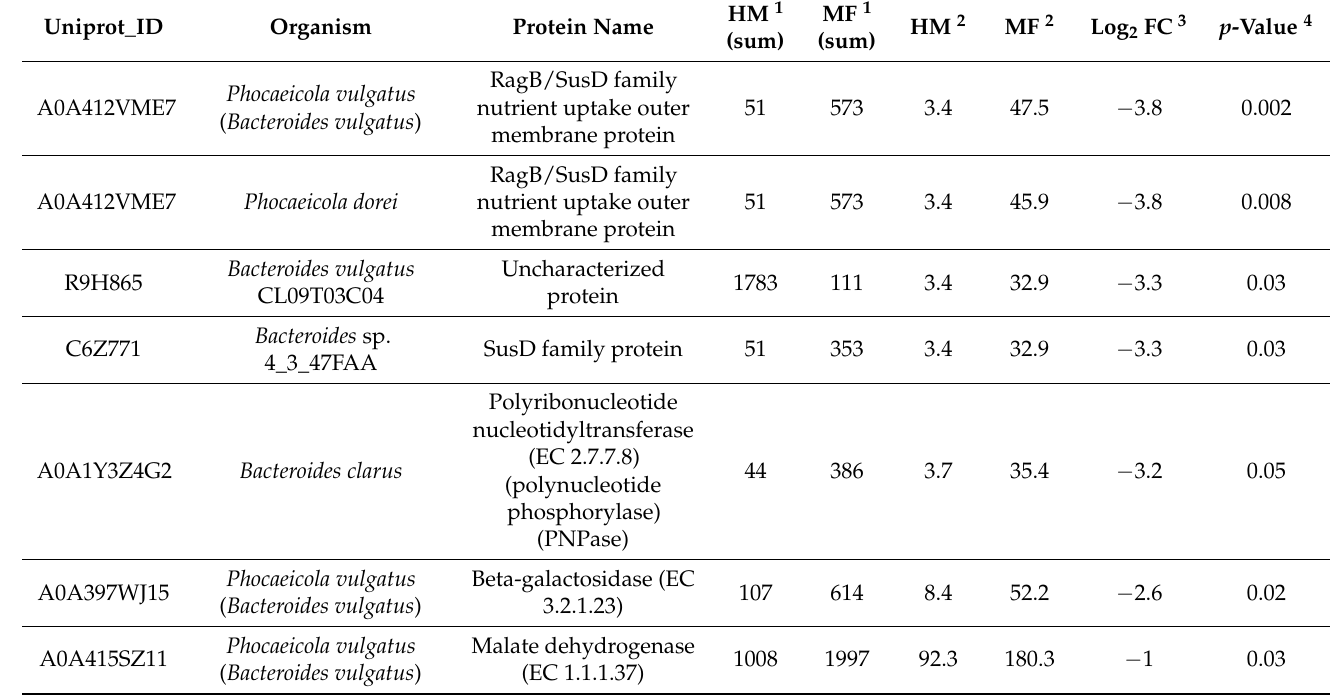
Table 2. Bacterial protein profile of cecal content of piglets ( n = 11/group) fed either with human milk (HM) or milk formula (MF) at PND